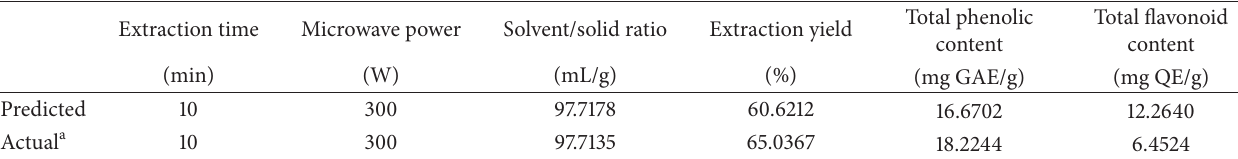
Table 4: The results of experimental verification.